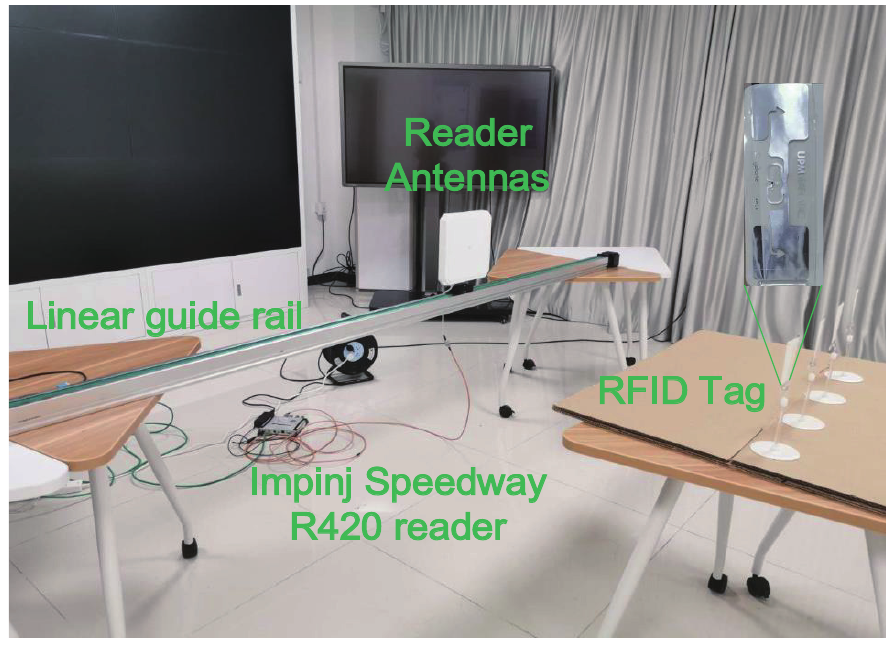
Figure 8. Experimental environment and